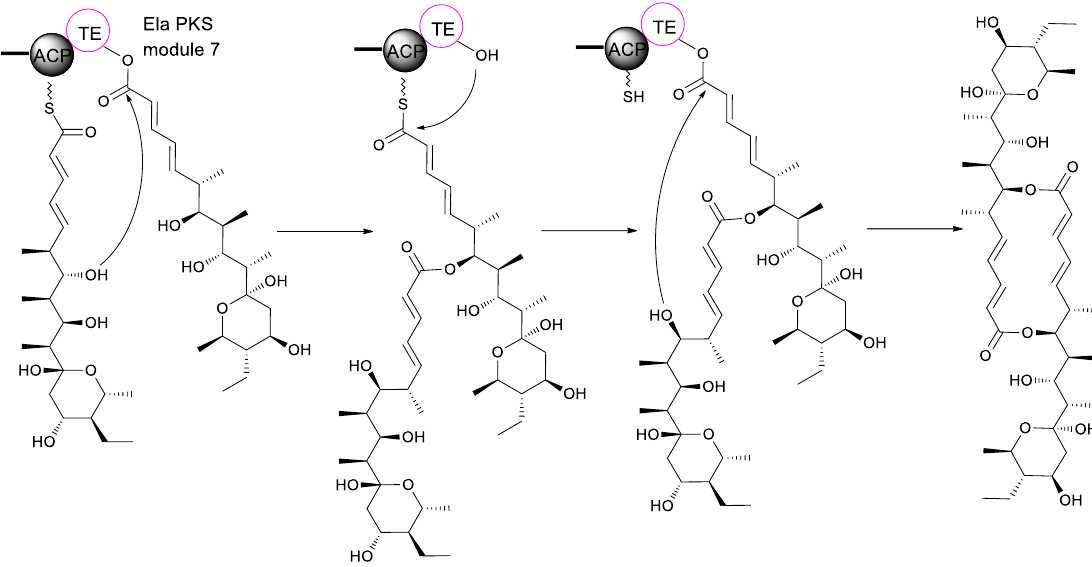
Figure 4. Biosynthetic mechanisms for the formation of elaiophylin diolide.